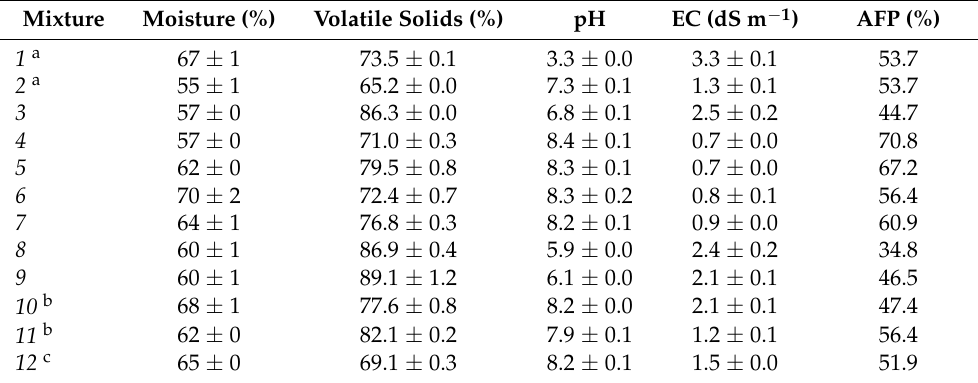
Table 4. Physico-chemical characteristics of the